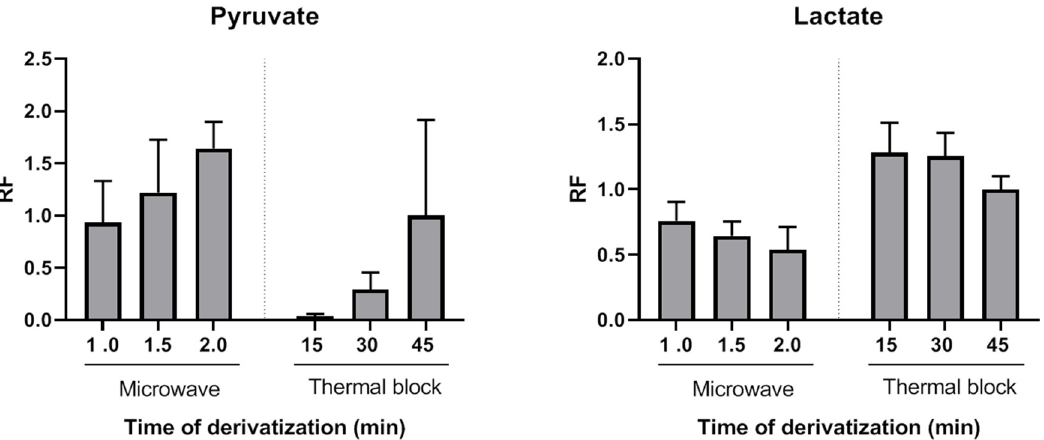
Figure 1. Comparison of derivatization yields of pyruvate and lactate after quinoxalinol deritvatitzation step performed using microwave or thermal block at different incubation times (mean of three plasma pools). RF: response factor.